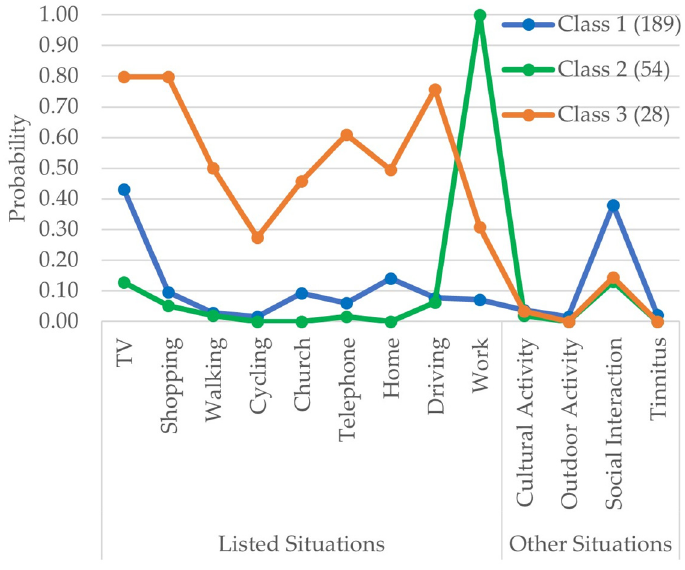
Figure 4. The item response probabilities for situations where HA users always preferred to put on their HAs with respect to each latent class. The legend also shows the number of participants in each class. The situations listed in the questions are in the “listed situation” group, and the “other situation” group are situations that are derived from the theme analysis of the free-hand text responses delivered by the HA users using the “other”